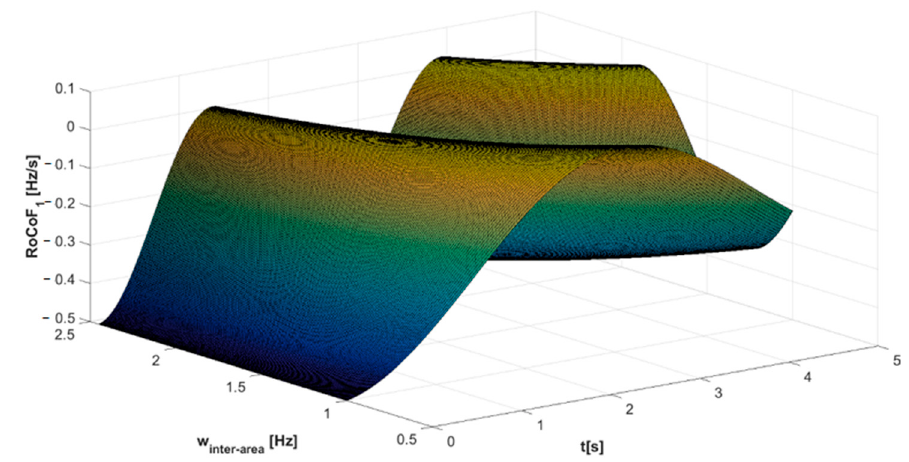
Figure 5. The value of RoCoF in area 1 for different frequencies of inter-area oscillations.